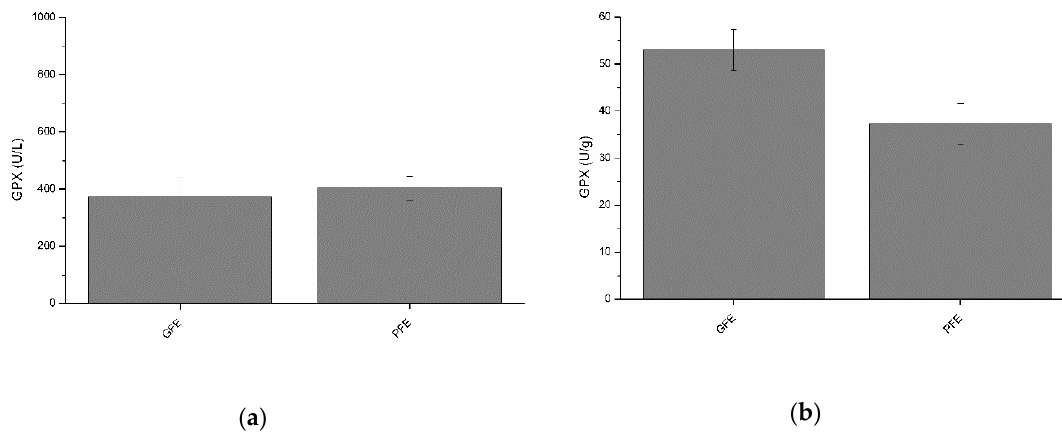
Figure 3. Glutathione peroxidase activities in stallion seminal plasma (mean ± SEM): ( a ) total activity; ( b ) specific activity. No significant ( p > 0.05) differences between good (GFE) and poor freezability ejaculates (PFE) were observed.